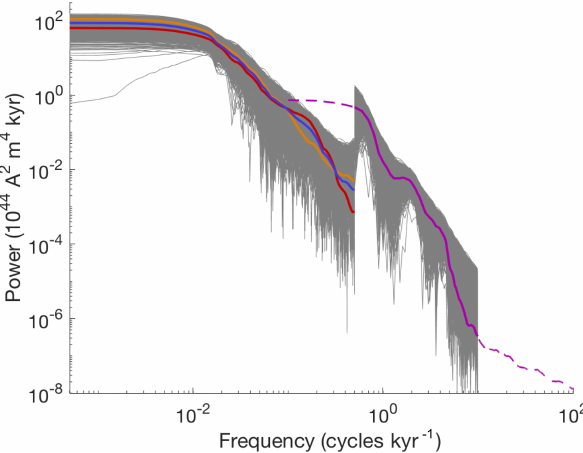
Figure 5. Data and error models for low and high frequencies. Or- ange: PSD of Sint-2000. Red: PSD of PADM2M. Blue: mean of PSDs of Sint-2000 and PADM2M ( y lf ). Grey (low frequencies): 5 × 10 3 samples of the error model ε lf added to y lf . Dashed purple: PSD of CALS10k.2. Solid purple: PSD of CALS10k.2 at frequen- cies we consider ( y hf ). Grey (high frequencies): 5 × 10 3 samples of the error model ε hf added to y hf